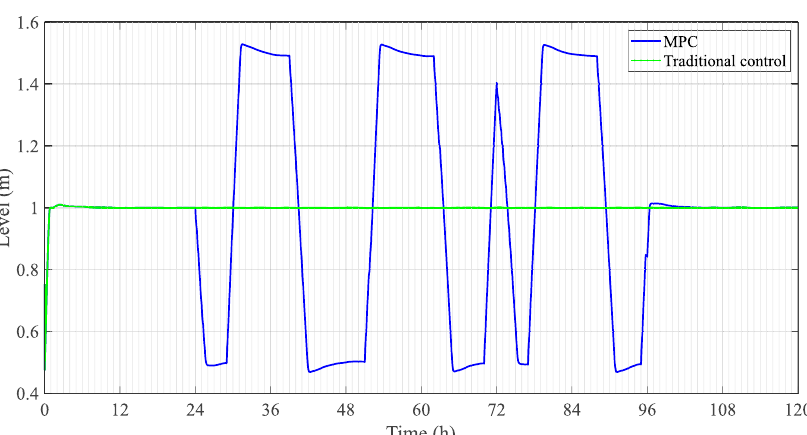
Figure 7. Low-pressure separator level of the single-objective case study with the MPC and the traditional control